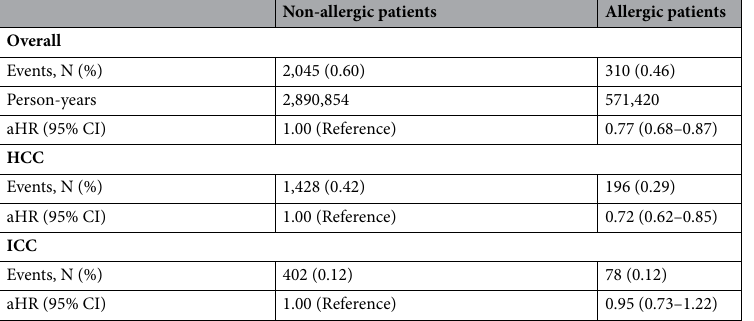
Table 2. Association of the history of allergic diseases with risk of liver cancer incidence. Hazard ratio calculated by Cox proportional hazards regression analysis after adjustments for age, sex, body mass index, Charlson comorbidity index, household income, smoking, alcohol consumption, physical activity, systolic blood pressure, fasting serum glucose, total cholesterol, history of hepatitis B virus/hepatitis C virus infection, liver cirrhosis, and the number of outpatient visits. N number of people, aHR adjusted hazard ratio, CI confidential interval, HCC Hepatocellular carcinoma, ICC intrahepatic cholangiocarcinoma.